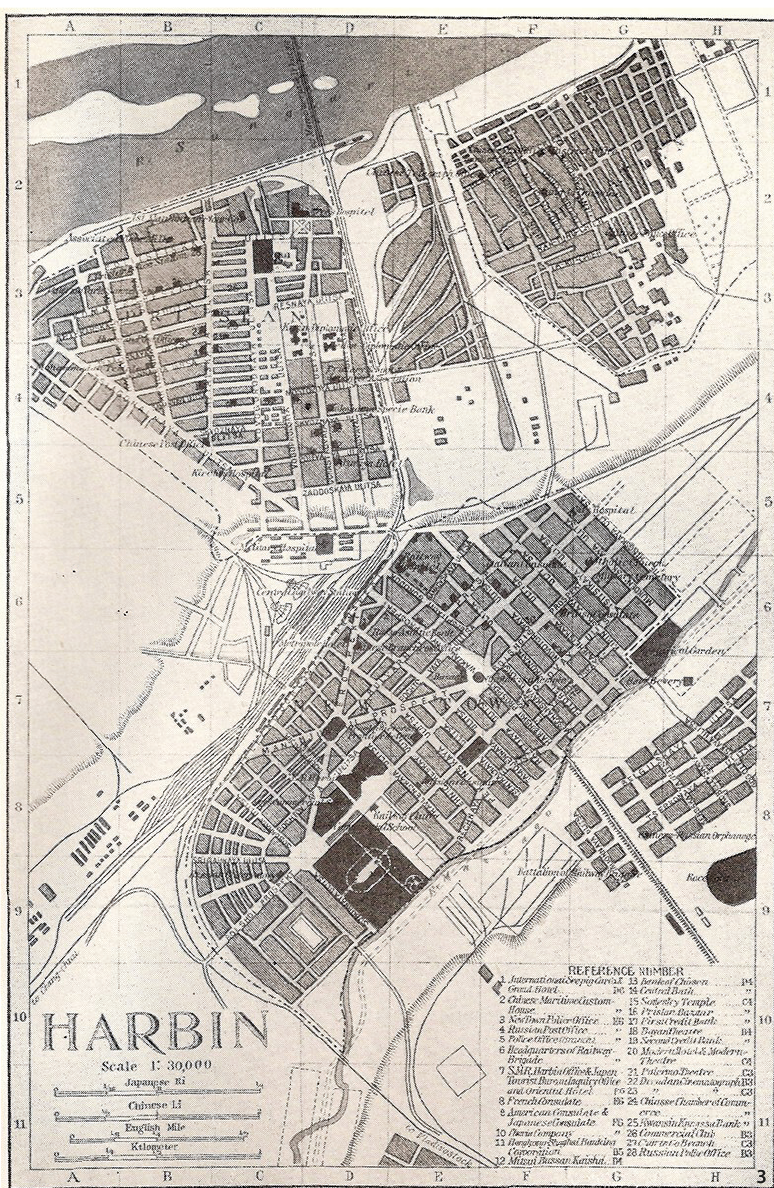
Figure 3 The Russian urban plan for Harbin, a city created at the end of the 19 th century by the construction of the Trans-Siberian Railway, ‘one of the greatest arteries of traffic the world has ever seen [and] one of the chief factors in shifting the centre of gravity of the world’s trade,’ and today boasting a population over 10 million (Colquhoun 1898, 327–328) (Source: the author).